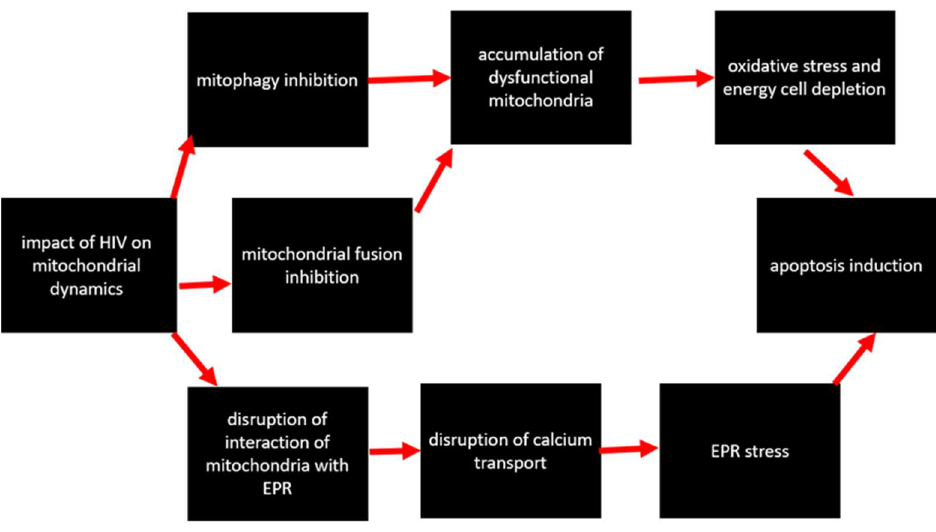
Figure 5. Impact of HIV on mitochondrial